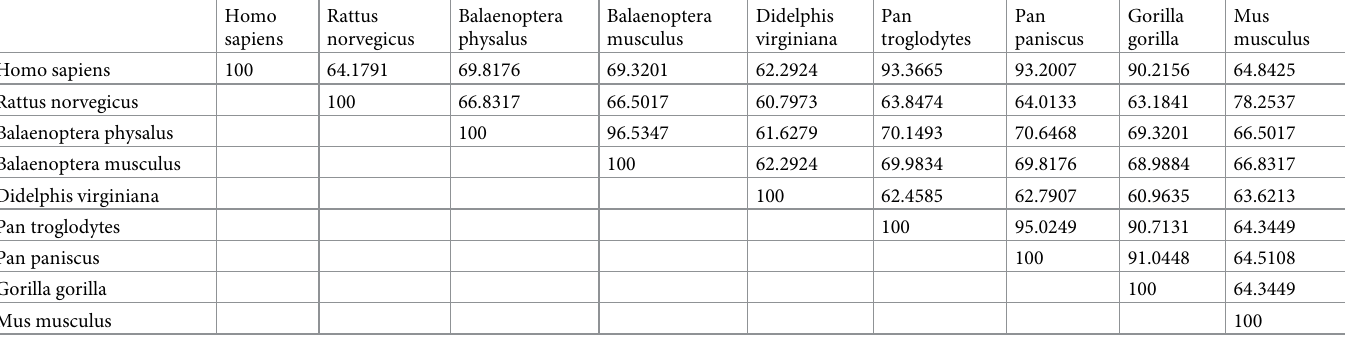
Table 1. The parameter Identity of the HELIOS method in the quantitative measurement of homology. The Identity reports the number of exactly matched characters of two compared sequences (in percentage) aligned by the HELIOS method, assuming the “Nine ND5 protein sequences dataset” [53].